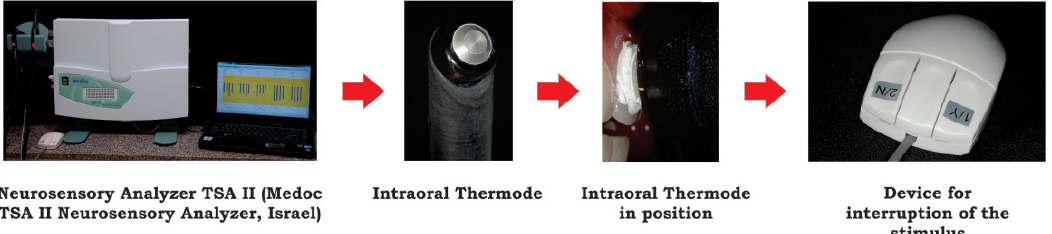
Figure 2- Scheme of the neurosensory analysis using the equipment TSA